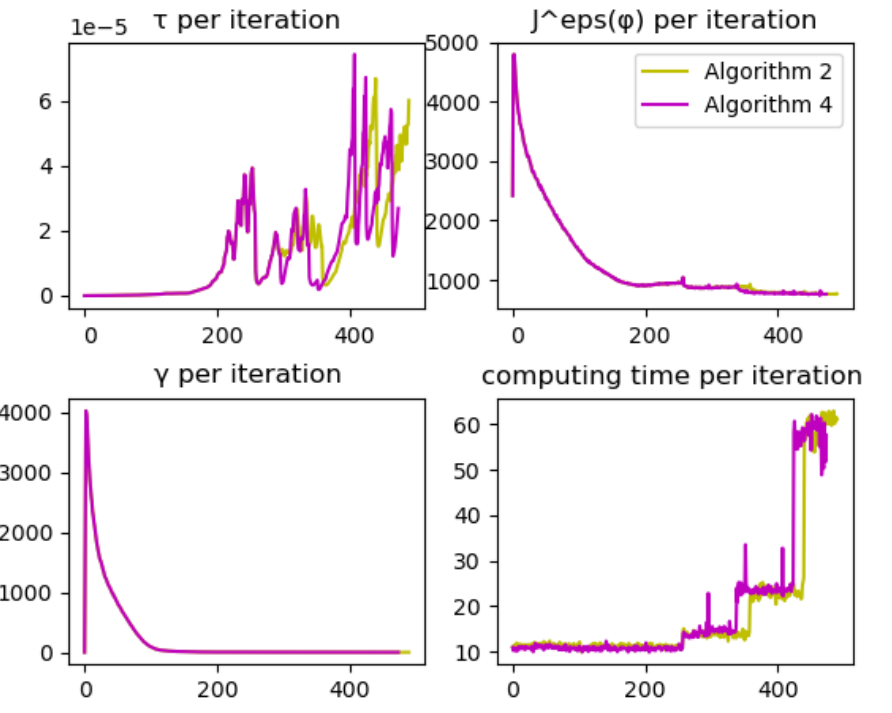
Figure 7. Comparison of metrics between Algorithms A2 and 2.